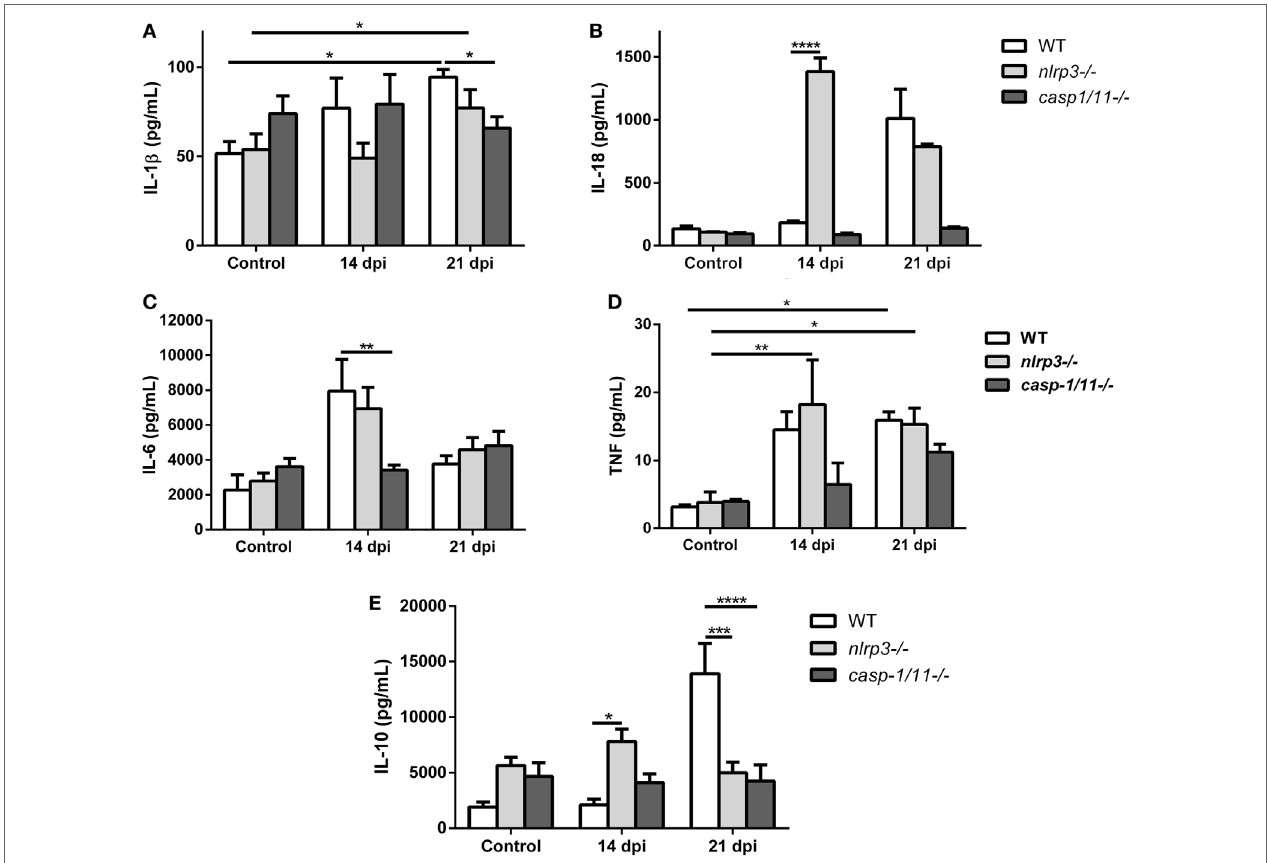
FigUre 5 | Differential systemic levels of cytokines in wild type (WT), nlrp3 − / − , and caspase-1/11 − / − mice during Trypanosoma cruzi infection. Plasma levels of the indicated cytokines were determined in uninfected and infected WT, nlrp3 − / − , and caspase-1/11 − / − at 14 and 21 days post infection. (a) IL-1 β , (B) IL-18, (c) IL-6, (D) tumor necrosis factor, and (e) IL-10 were measured by ELISA Sandwich. Data are shown as mean ± SEM from one of three representative experiments; n = 3–6 mice per group. Statistical significance was evaluated by two-way ANOVA followed by Bonferroni post hoc test. * p < 0.05; ** p < 0.01; *** p < 0.001; **** p <